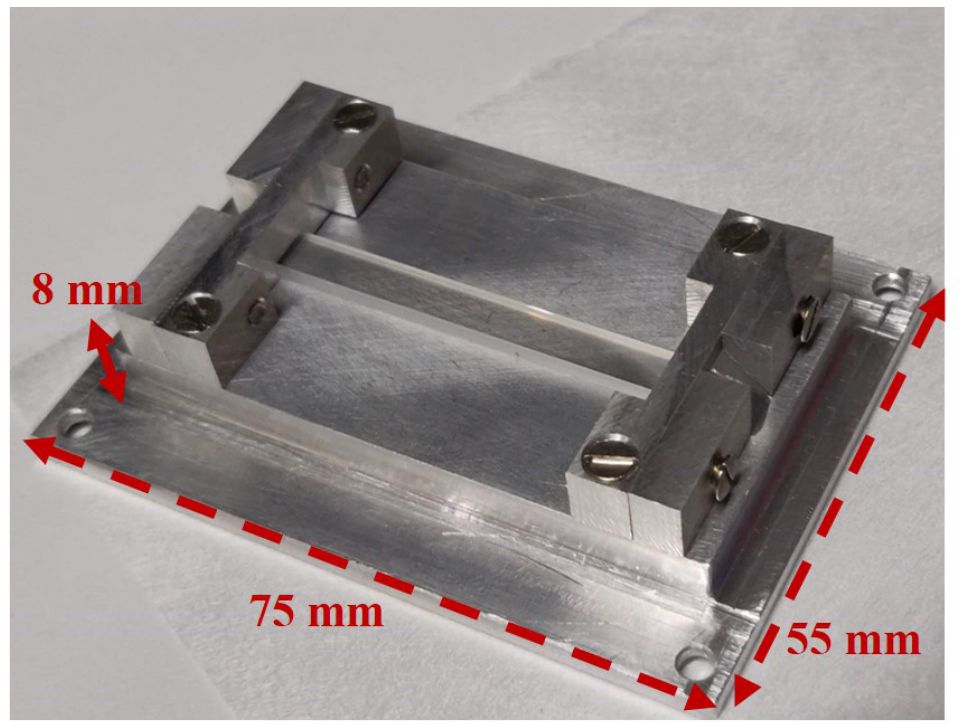
Figure 15. Sensing crystal